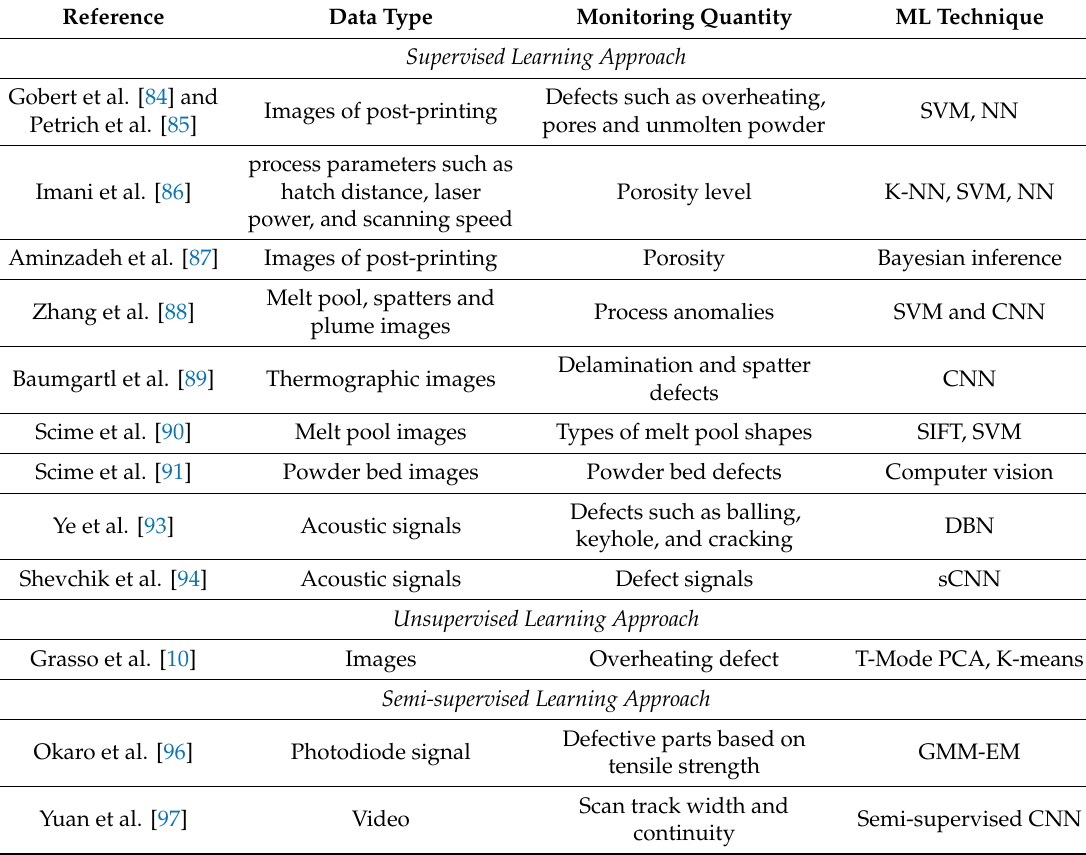
Table 1. List of the literature on the processing of L-PBF in situ data using machine learning